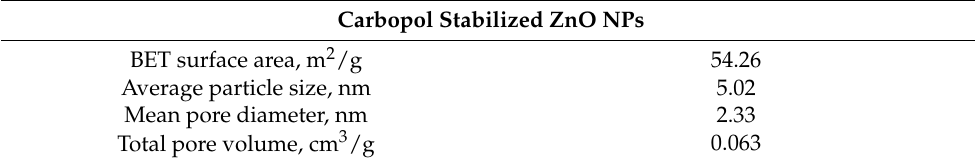
Figure 5. N 2 gas adsorption/desorption isotherm of the synthesized Carbopol/ZnO hybrid nanopar- ticles gel. Table 3. BET parameters of the synthesized Carbopol/ZnO hybrid nanoparticles